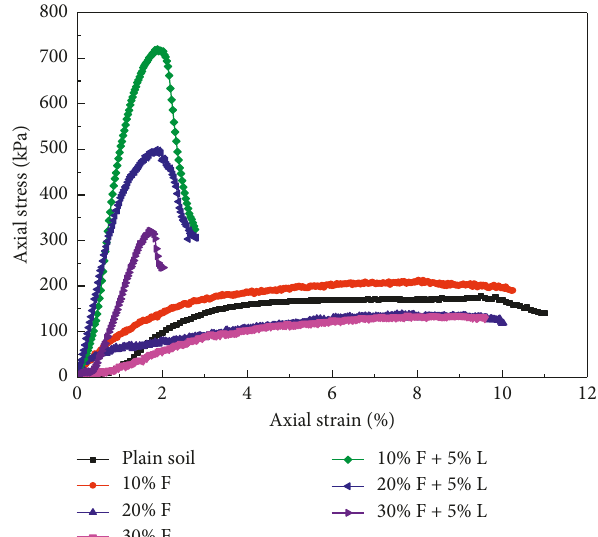
Figure 7: Stress-strain curves of stabilized soil under different mix proportions (7 days).